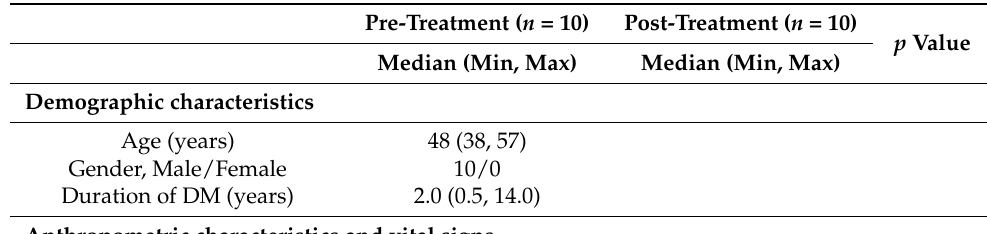
Table 1. Clinical parameters before and after YH1